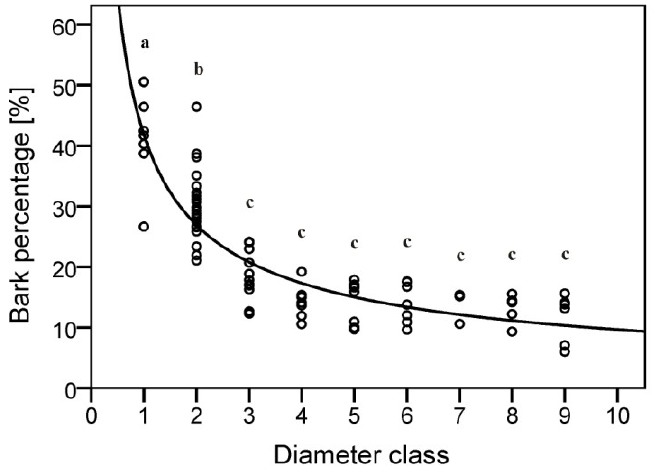
Figure 3. Biomass model for dry bark biomass by diameter class. Parameters of the model applicable to Equation 3 are shown in Table 7. Mean values with the same letter are not significantly different (Tukey HSD, significance level p < 0.05, p -values: a = 1.0, b = 1.0, c =